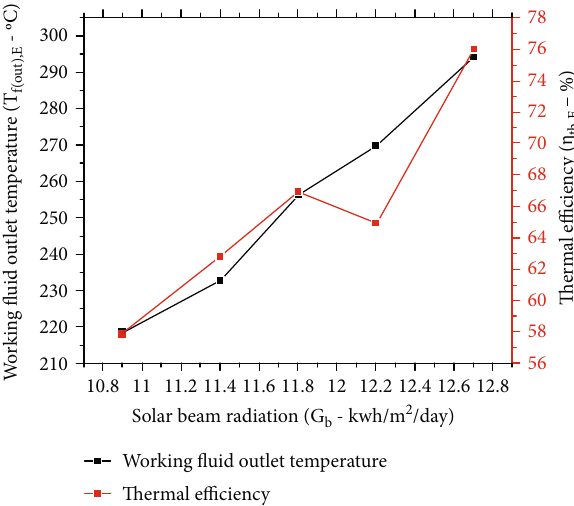
Figure 16: Behavior of working fl uid outlet fl ow velocity and working fl uid inlet temperature from January to May.